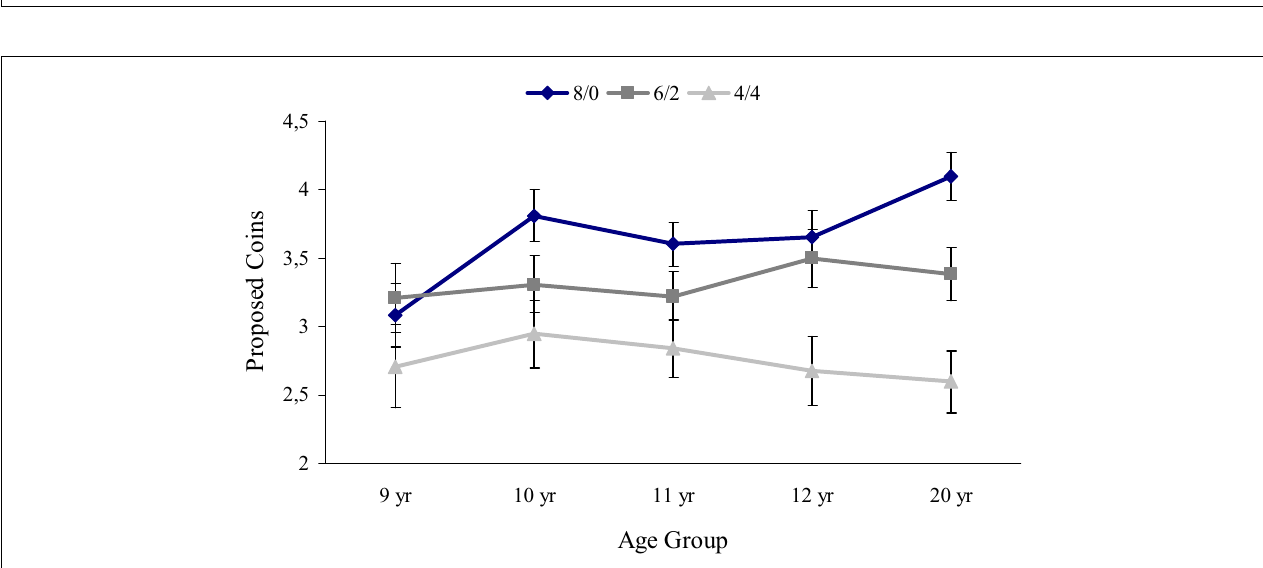
FIGURE 4 | Mean amount of coins and standard errors offered in the 3 conditions with a total number of 8 coins (i.e., 8/0, 6/2, and 4/4) in five age groups.